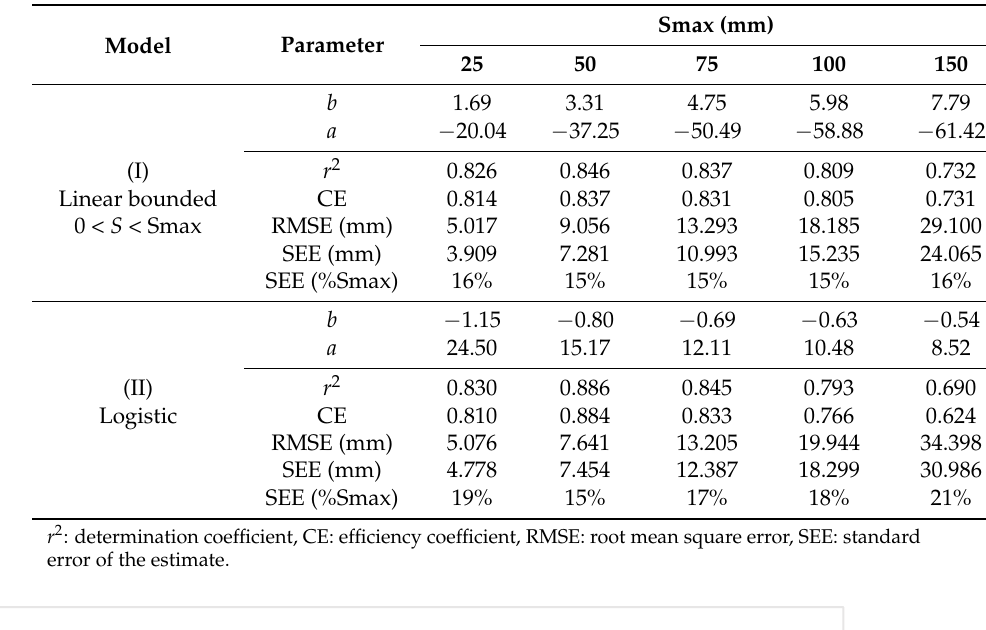
Table 2. Regression parameters and performance indicators for models I and II that were applied with different soil water storage capacities, Smax (SM, %, independent variable; S , mm, dependent variable; n = 168).